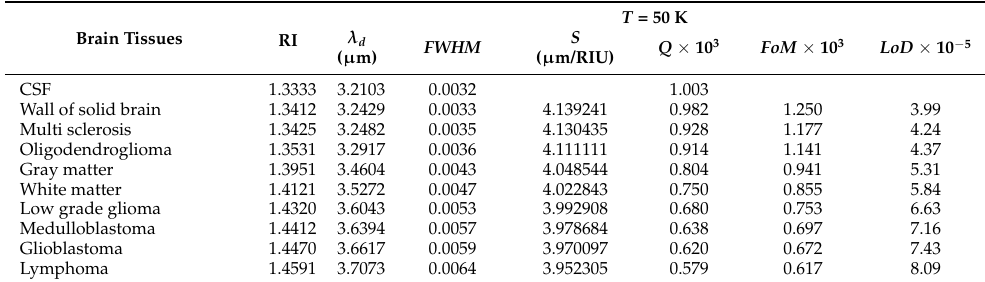
Table 4. The numeric values of parameters central wavelength of defect mode ( λ d ), FWHM, sensitivity ( S ), quality factor ( Q ), figure of merit ( FoM ) and limit of detection ( LoD ) associated with our biosensor ( AB ) 2 CDC ( AB ) 2 under optimum condition which describe the